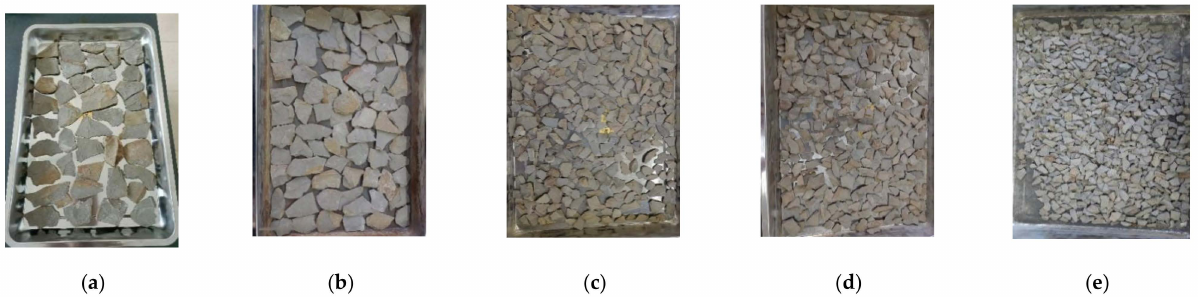
Figure 3. Specimens for various particle sizes: ( a ) 1# (40–60 mm); ( b ) 2# (40–60 mm); ( c ) 3# (20–40 mm); ( d ) 4# (20–40 mm); ( e ) 5# (10–20